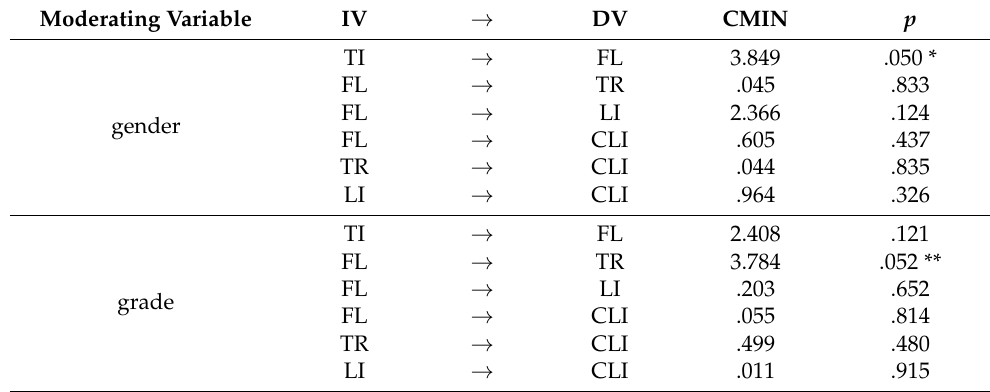
Table 11. Results of mediation effect.